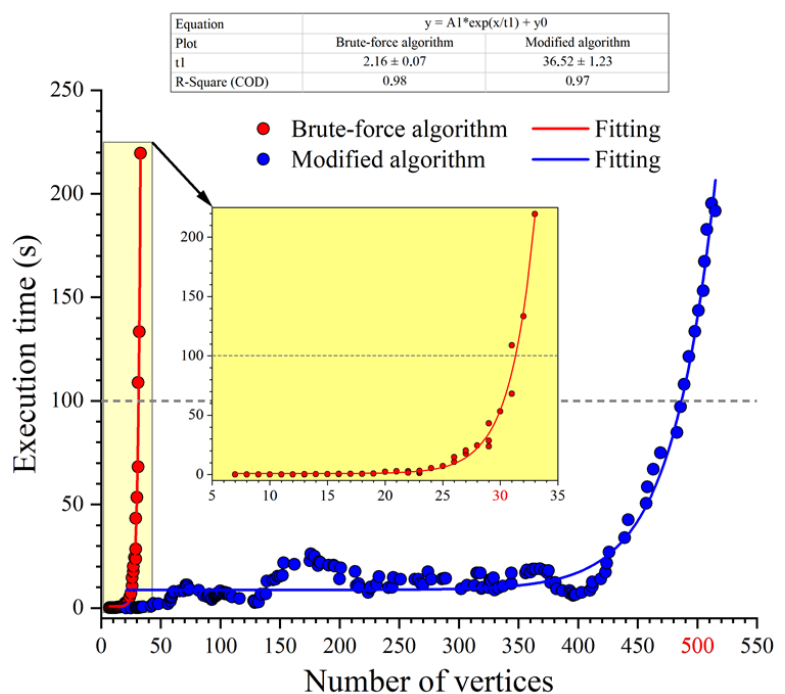
Figure 9. The comparison of the experimentally determined time complexity for modified algorithm and standard brute-force search method.